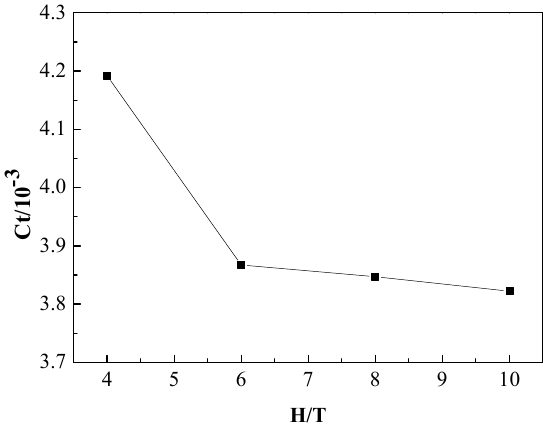
Figure 10. The total resistance coefficients of the KCS scaled model with different depth/draft ratios (H/T). Table 14. The results of resistance, sinkage and